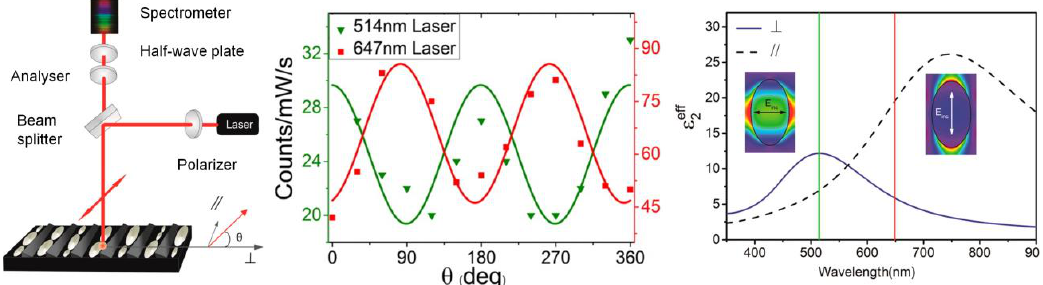
Figure 15. Left: Setup for Raman measurements used. Middle: Normalized intensity of the 1079 cm − 1 band of 4-mercaptobenzonitrile (MBN) adsorbed on anisotropic Ag nanoparticle arrays created by metal evaporation on rippled silicon substrates as a function of θ obtained with the 514 nm (green triangles) and the 647 nm (red squares) excitation. The respective solid lines correspond to fits of a cos 2 θ (green) and sin 2 θ (red) function to the data. Right: Imaginary part of the effective dielectric function of the Ag film parallel and perpendicular to the long axis of the ripples. Adapted with permission from [116]. Copyright 2016 American Chemical Society.